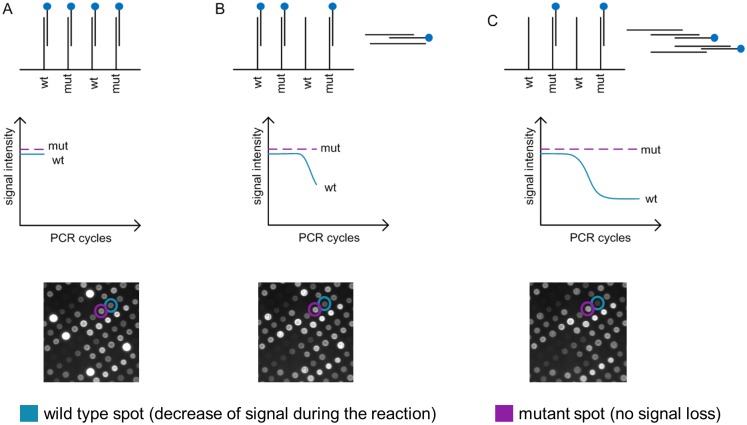
Detection principle of the CMA-based SNP assay.A: For each target there are probes representing the wild type (wt) and mutant (mut) genotypes spotted on a solid phase. Initially the Cy5 labeled reporter oligonucleotides bind to the complementary probes onto the array. B: The template (e.g. wild type DNA) is amplified by PCR and the reporter oligonucleotides bind preferentially to the generated complementary amplicon. A decrease of signal intensity at matched array spots (e.g. wild type probes) is detected. C: The overall signal intensity decreases proportional to the concentration of the amplified target. In this example the signal of the mutant spots remains unchanged.